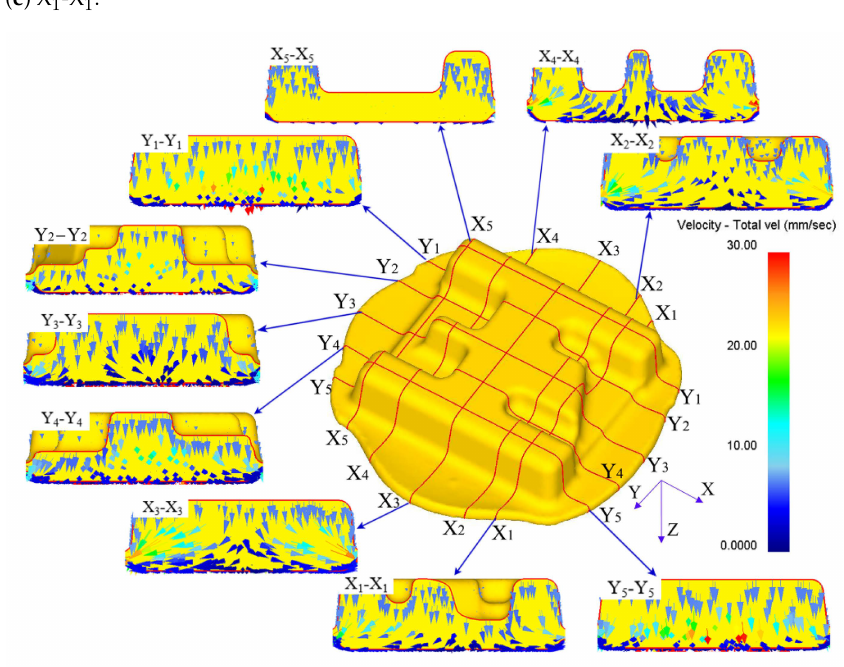
Figure 10. Velocity field distribution of different